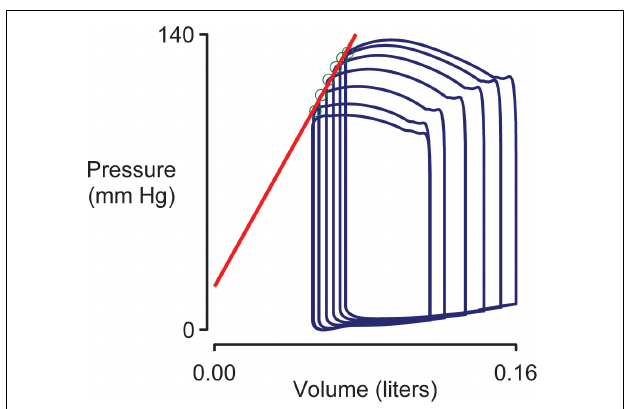
FIGURE 4 | Simulated pressure volume loops and the End Systolic Pressure Volume Relationship (ESPVR). Ventricular pressure plotted against ventricular volume for beats 10–15 of the simulation shown in Figure 2 . The ESPVR was calculated as the slope of a regression line (shown in red) fitted to the top-left corner (green circles) of each pressure-volume